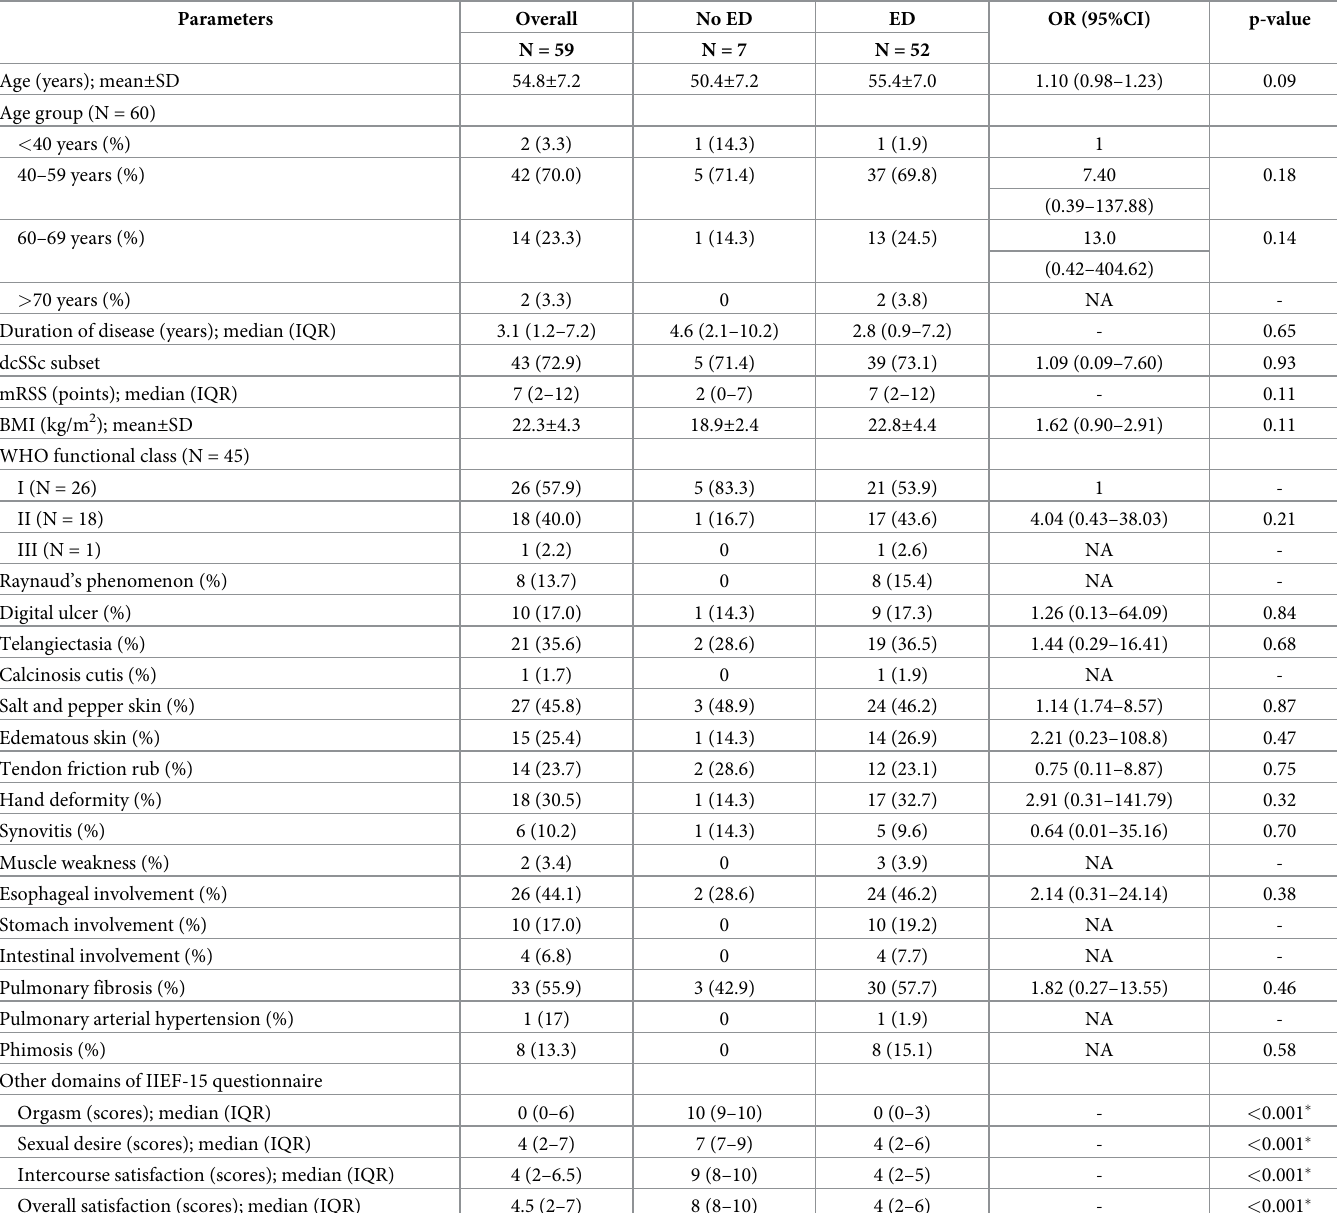
Table 1. Overall clinical characteristics and clinical association with ED by univariate analysis.